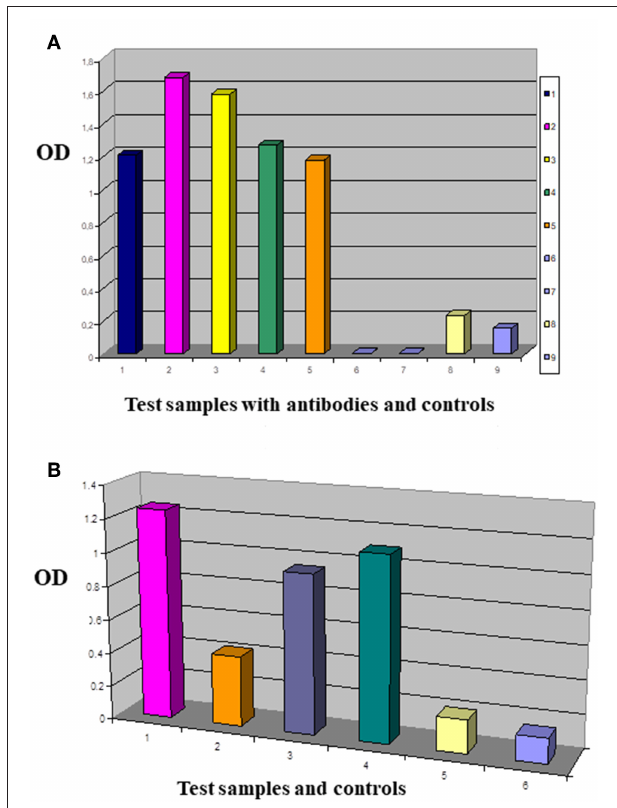
FIGURE 5 | Comparing the tumor membrane binding capacity of antibody fragments. This is an enzyme labeled Immunosorbent Assay performed with test antibodies and antibody fragments in Nunc MaxiSorp ® flat-bottom 96 well plates precoated with native tumor cell membrane preparations. IDC breast primary tumor cell culture membrane coated plates were reacted with antibodies of interest (A) : 1/MDA MB-231 panned sol scFv library (dark blue), 2/G2 sol scFvK (purple), 3/B2 sol scFvK (light green), 4/anti mucin antibody fragment (green), 5/HCBC3 anti GD3 antibody (orange), 8/medium control (yellow), 9/test/PBS background control (light blue). In the ELISA blocking assay two antibodies were used subsequently in one reaction (B) : 1/G2 scFv (purple), 2/HCBC3 (anti GD3) and G2scFv (orange), 3/HCBD1 (anti GD2) and G2scFv (violet), 4/IgG and G2scFv (dark green), 5/medium control (yellow), 6/background control with PBS (light blue). Optical density (OD) was measured at λ : 405nm when p - Nitrophenyl Phosphate substrate was added after using alkaline phosphatase conjugated antibody.